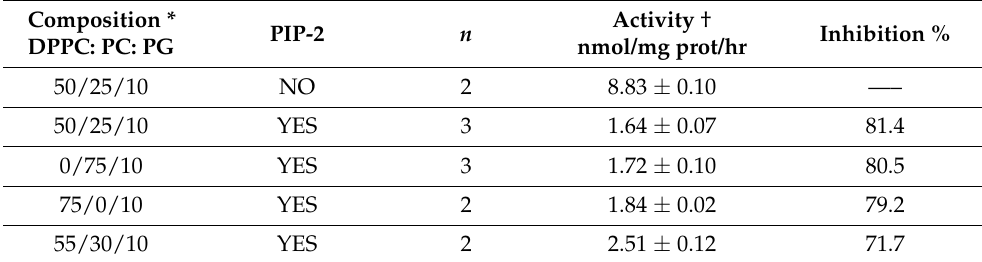
Table 2. Effect of liposomes composition on delivery of PIP-2 to lungs. PIP-2 in liposomes was delivered to mice by a bolus IV infusion. After 2 h lungs were cleared of blood and PLA 2 activity of the lung homogenate was measured. % inhibition = value relative to no PIP-2. * % of total lipid; all liposomes also contained 15% cholesterol. † Mean ± SD for n = 3 or ± range for n =